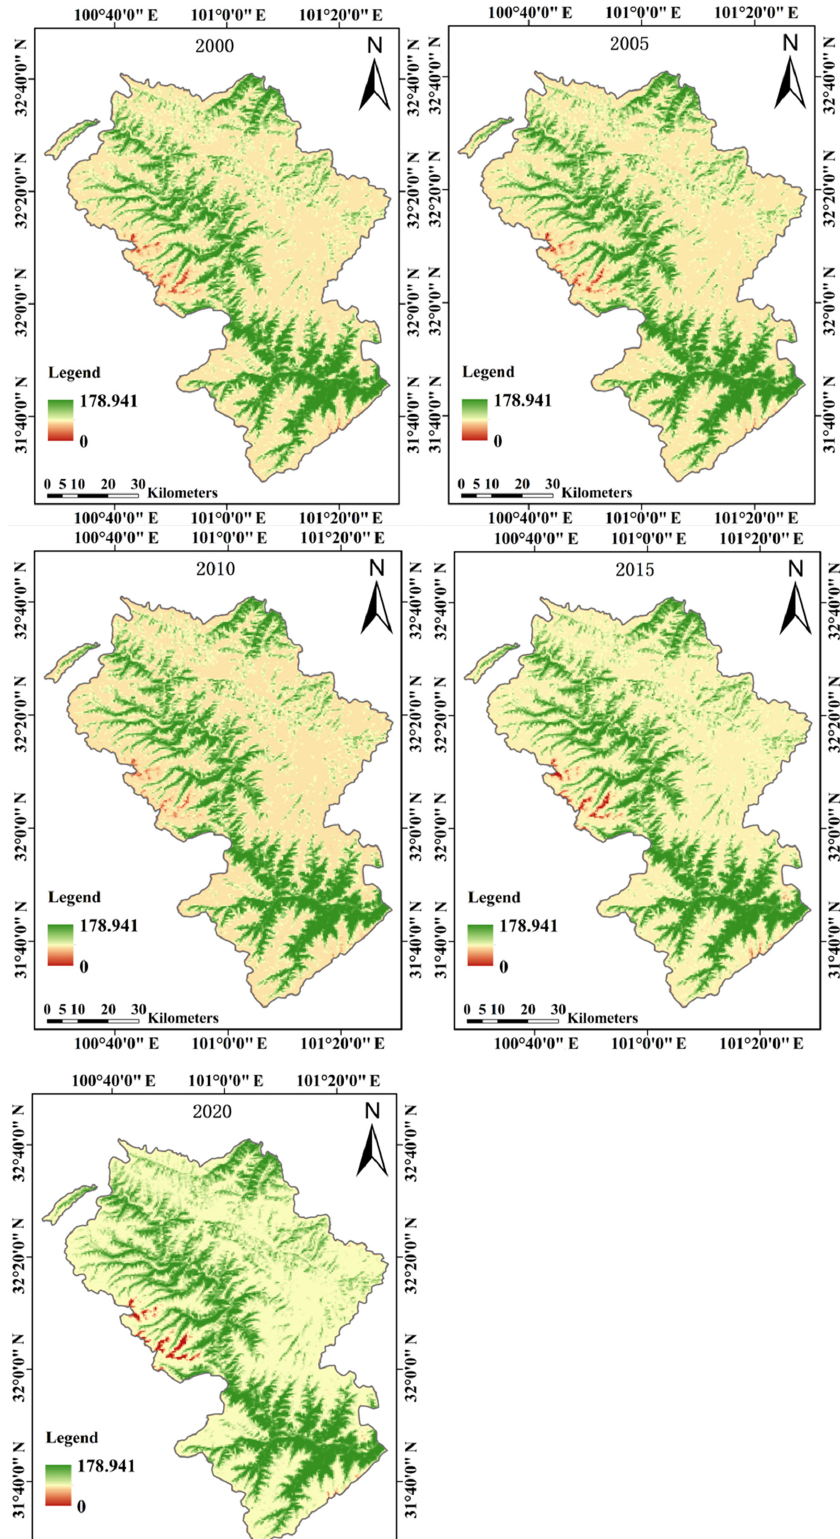
Figure 6. Biological richness index of Rangtang County.